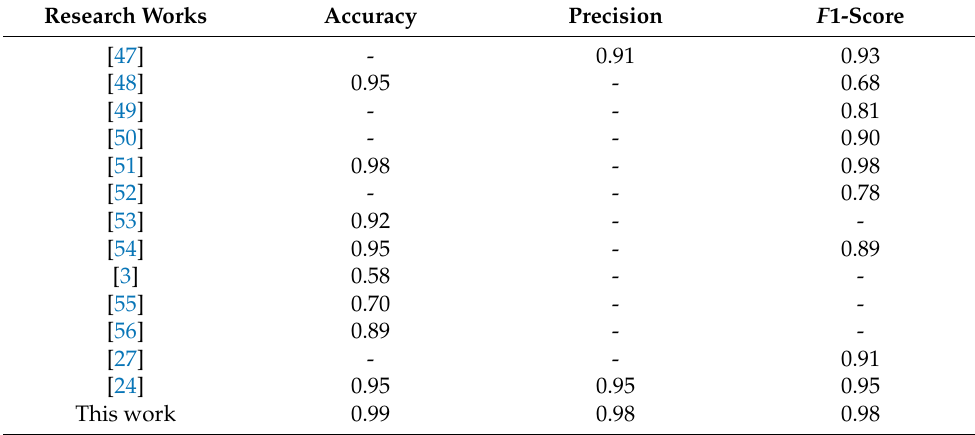
Table 9. Performance